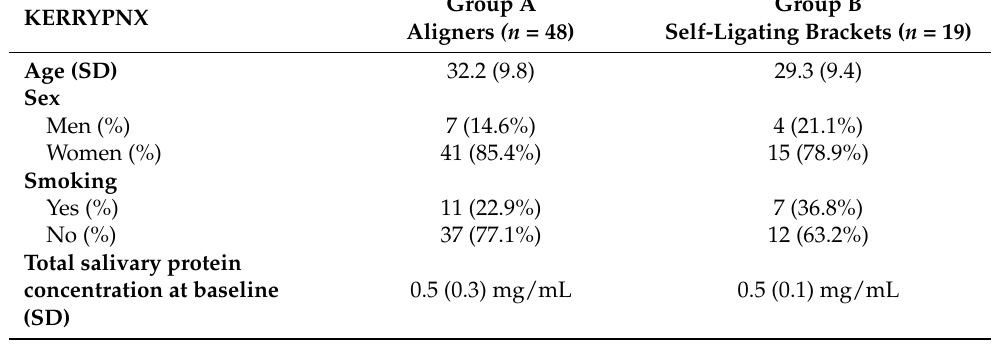
Table 1. Treatment group characteristics and total salivary protein concentration at baseline.